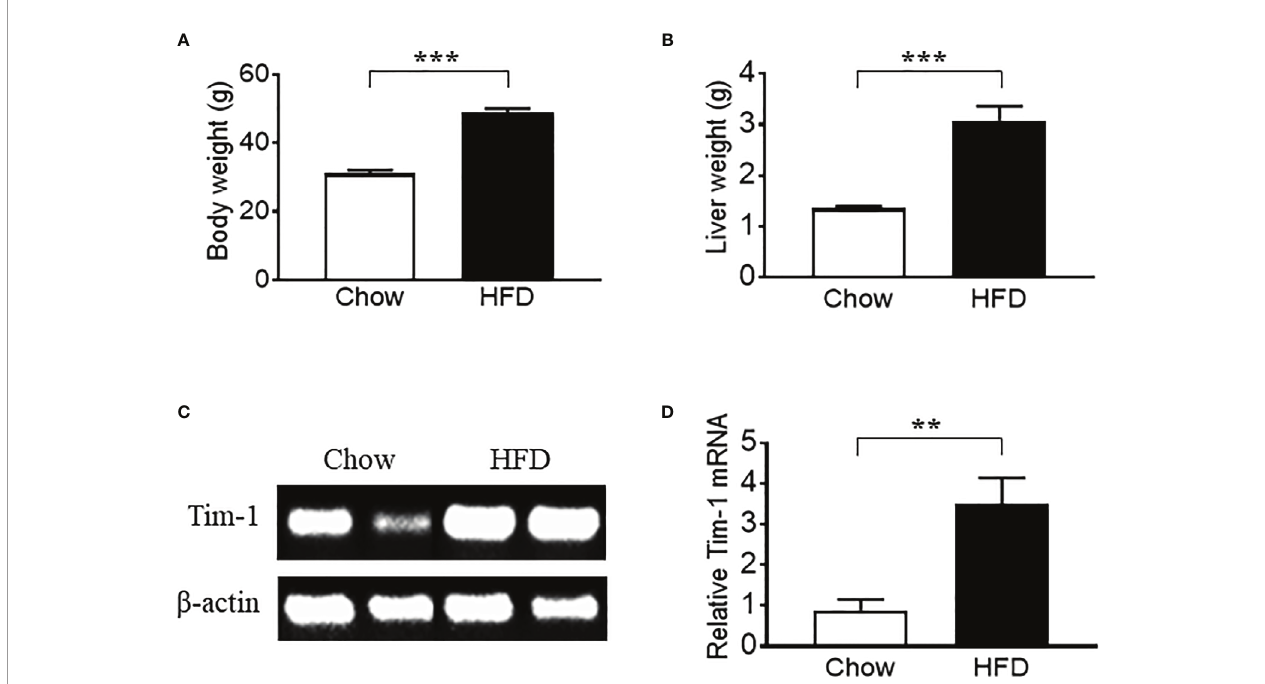
FIGURE 1 | High-fat diet (HFD) feeding for 6 months led to an upregulation of hepatic Tim-1 in wild-type C57BL/6 mice. (A, B) Increased body weight and liver weight in HFD-fed mice compared to chow controls. (C, D) Representative gel and quantitative analysis after 35 cycles RT-PCR revealed an upregulation of Tim-1 gene expression in HFD mouse liver. Values are mean ± SEM. n = 5-6 mice; ** P <0.01, *** P <0.001 vs. chow control